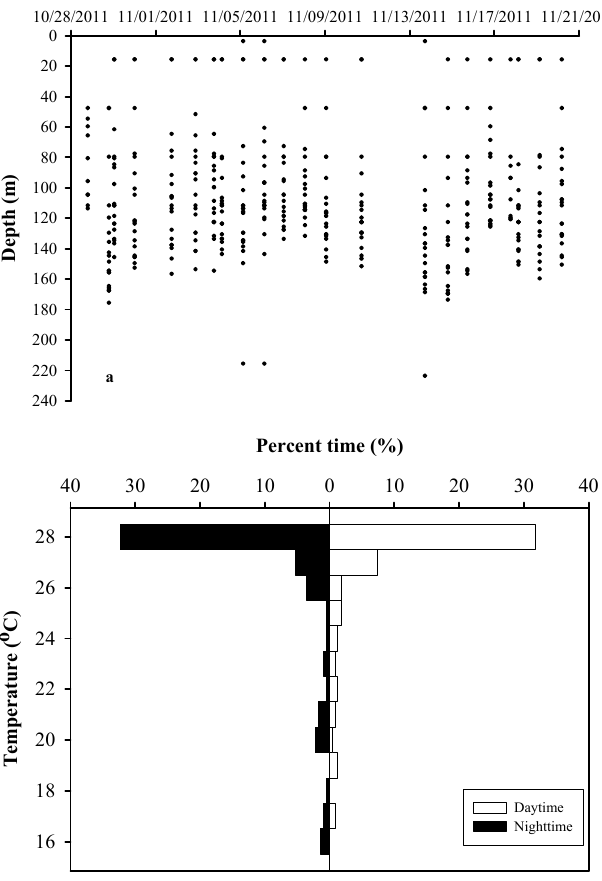
Fig. 6. Vertical movement distribution (a), and percentage of time spent at different temperature (b) for the fi sh bearing tag